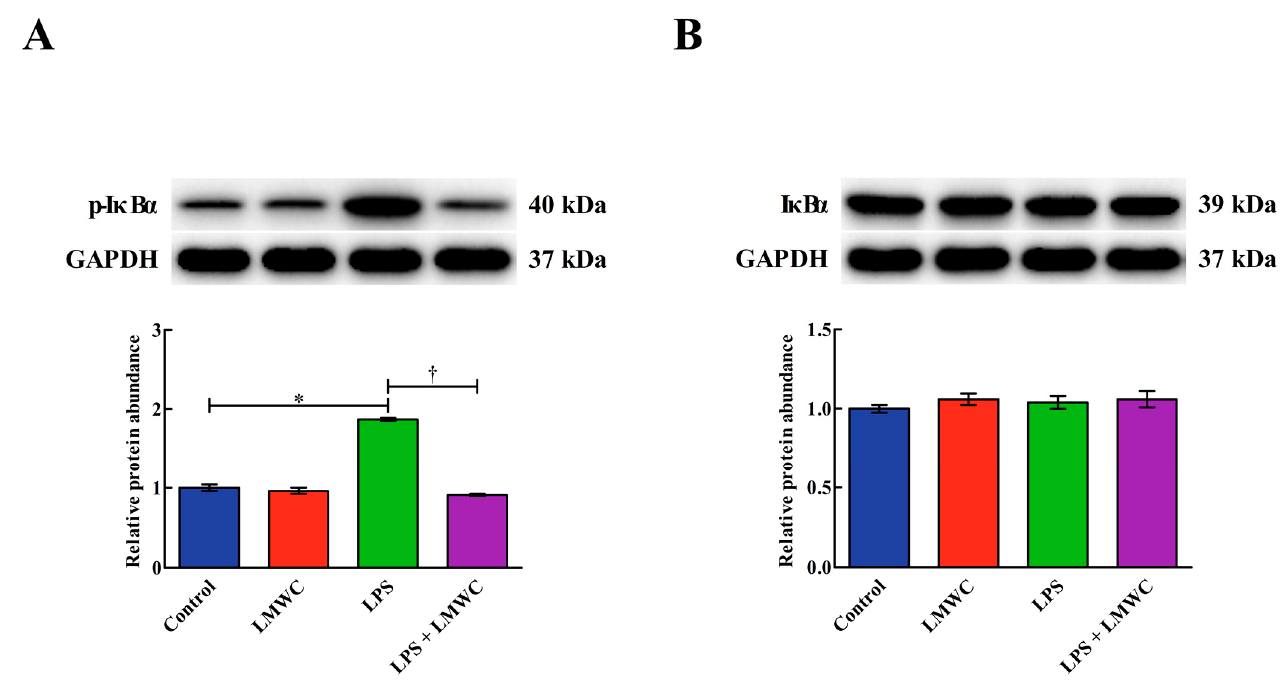
Figure 8. Effects of LMWC on the abundance of p-I κ B α and I κ B α protein in LPS-treated IPEC-J2 cells. ( A ) p-I κ B α : phosphorylated inhibitor of nuclear factor- κ B α . ( B ) I κ B α : inhibitor of nuclear factor- κ B α . Cells were pretreated with LMWC (400 µ g/mL) for 2 h, followed by cotreatment with LPS (5 µ g/mL) for another 6 h. Data are presented as the mean ± standard error ( n = 4). * Means significant difference compared with the control group ( p < 0.05). † Means significant difference compared with the LPS group ( p < 0.05).